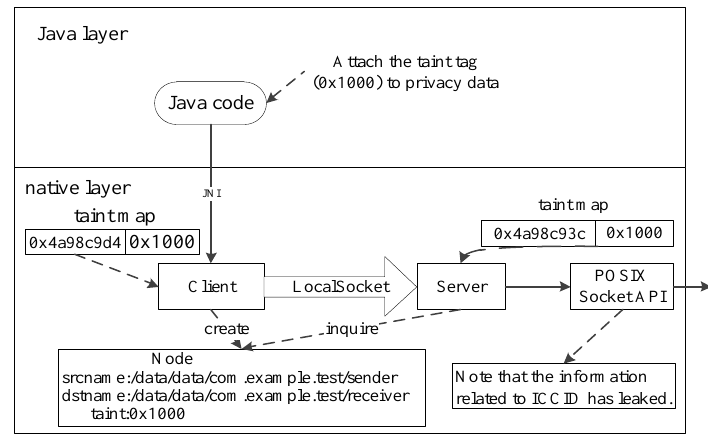
Figure 13. PoC for Case 2.